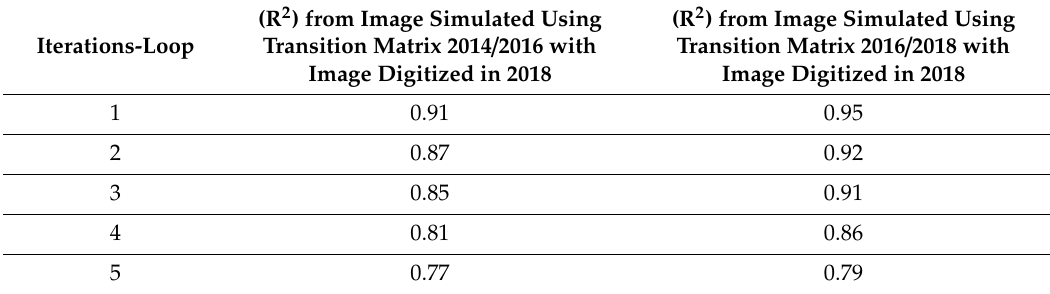
Table 1. Result comparison of built-up growth simulation using the CA-Markov model with visual interpretation.